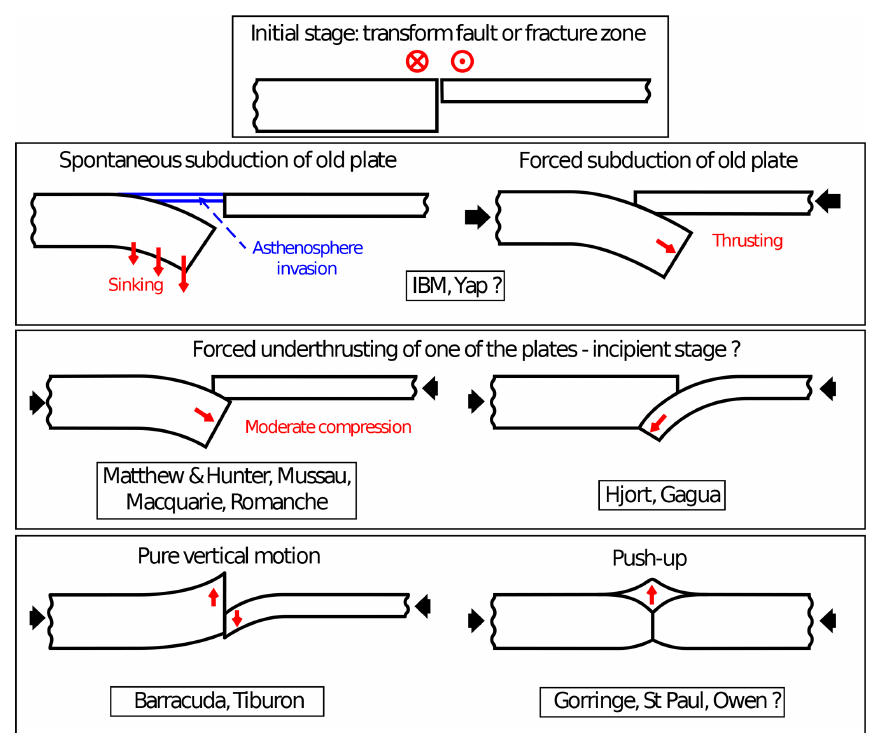
Figure 1. Various tectonic settings leading to vertical motion and/or convergence at transform plate boundaries, as detailed in Table 1. The convergent black heavy arrows represent far-field tectonic forces. The red light arrows outline the sense of motion of one plate with respect to the other. The red crosses and dots in circles indicate transform motion. The thicker plate is the older